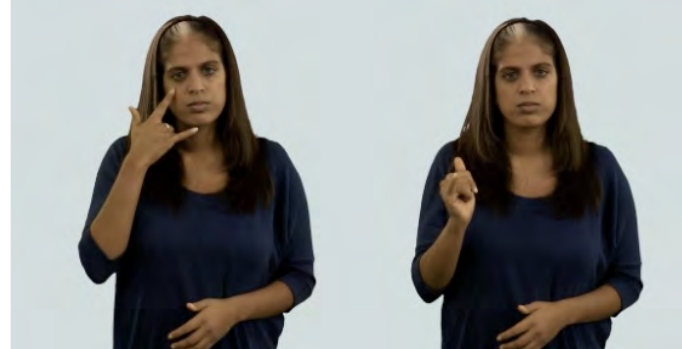
Figure 4. Single indicating verb check in BSL